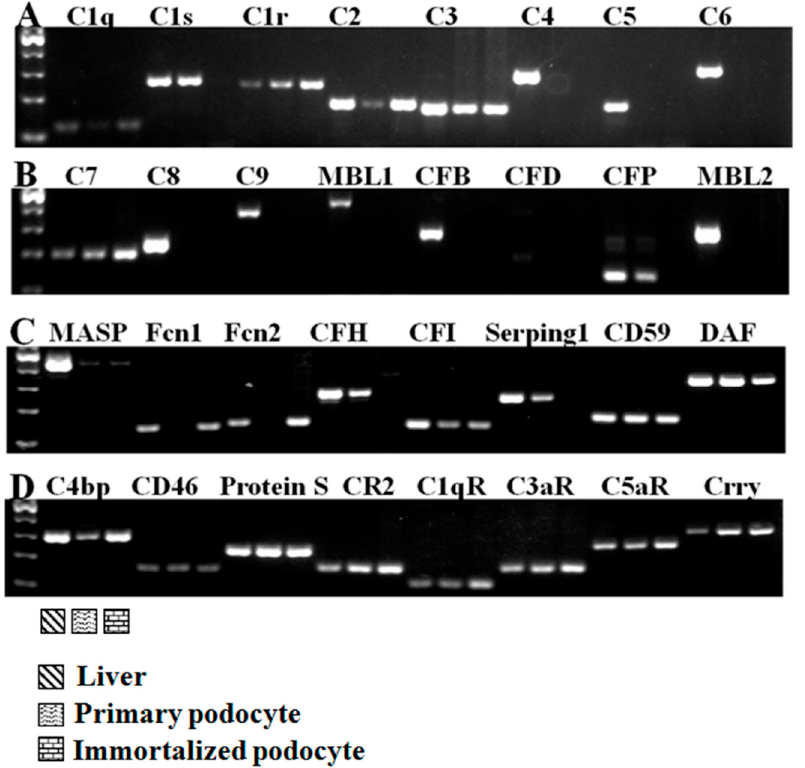
Figure 1. The expression of complement genes in primary cultured murine podocytes and immortalized murine podocytes. ( A – D ) Primary cultured podocytes and immortalized murine podocytes expressed the complement factors C1q, C1r, C2, C3, C7, MASP, CFI, DAF, CD59, C4bp, CD46, Protein S, CR2, C1qR, C3aR, C5aR, and Crry. Neither the primary nor the immortalized podocytes exhibited specific bands for C4, CFB, CFD, MBL1, MBL2, C5, C6, C8, or C9 (9/32). Total RNA from mouse liver tissue was used as a positive control. n = 3.